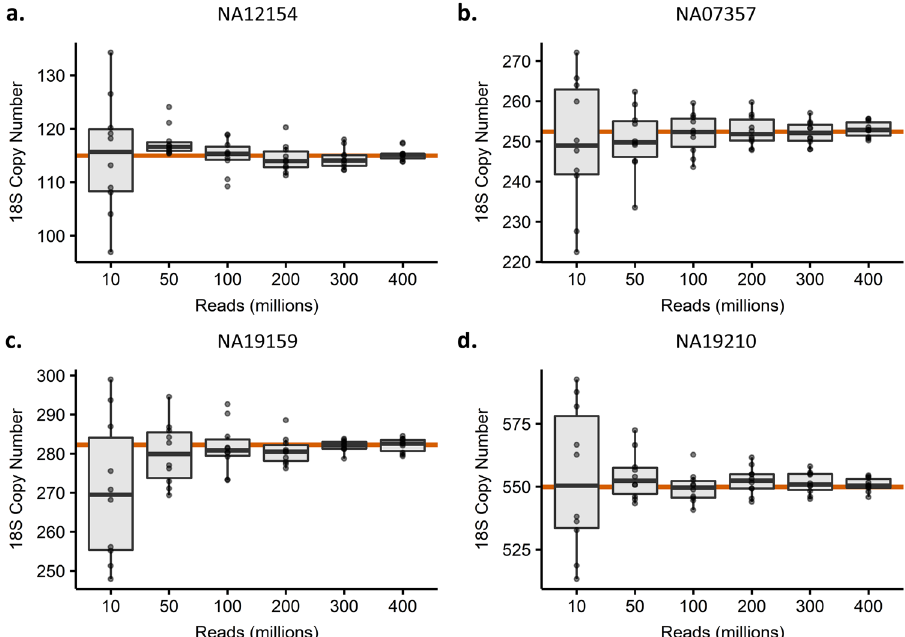
Figure 4. Read coverage downsampling of four high-coverage 1000 Genomes Project samples. ( a ) NA12154 has an 18S copy number of 115 in the full dataset. ( b ) NA07357 has an 18S copy number of 252 in the full dataset. ( c ) Has an 18S copy number of 282 in the full dataset. ( d ) NA19210 has an 18S copy number of 550 in the full dataset. Note different Y axis scales for each graph. Ten independent downsamplings were performed per